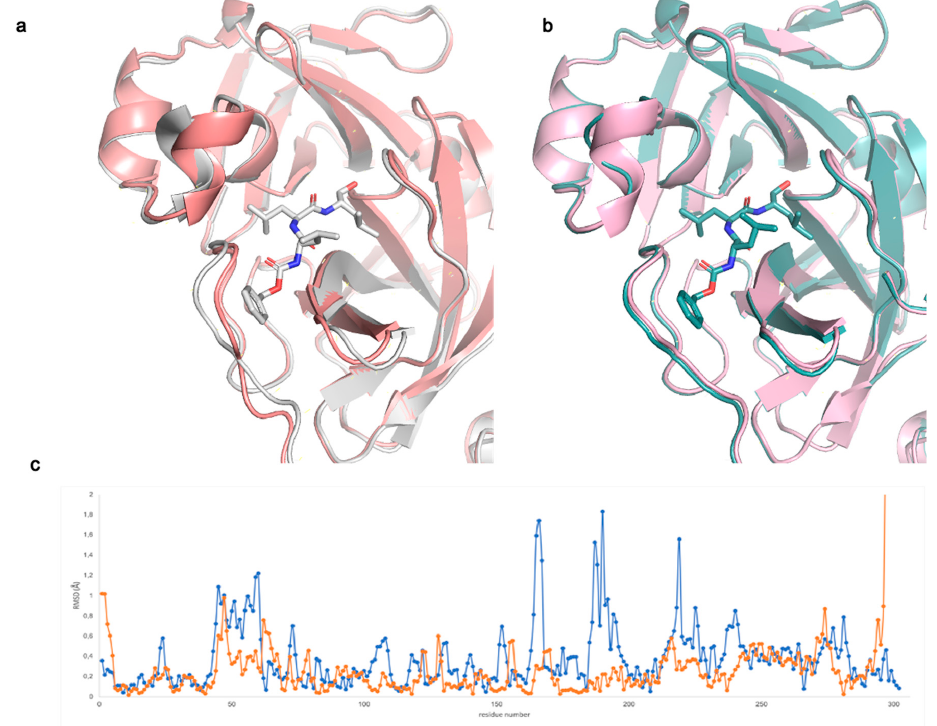
Figure 1. Comparison between Mpo apo and MG-132 complexed structures ( a ) in spacegroup C 2, grey (MG-132 bound, PDB ID: 7NF5) salmon (apo, PDB ID: 7ALH); ( b ) in spacegroup P 2 1 2 1 2 1 , teal (MG-132 bound, PDB ID: 7BE7) light pink (apo, PDB ID: 7BB2); ( c ) RSMD between C α of each residue of the apo and MG-132 bound structures in spacegroup C 2 (blue) and spacegroup P 2 1 2 1 2 1 (orange).